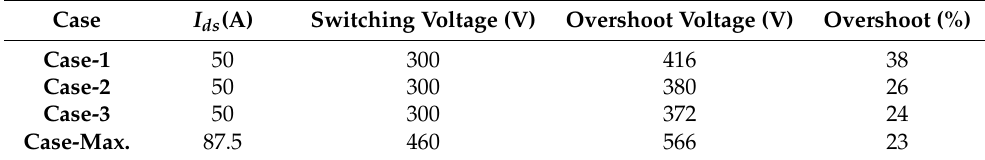
Table 6. V ds overshoot comparison table.